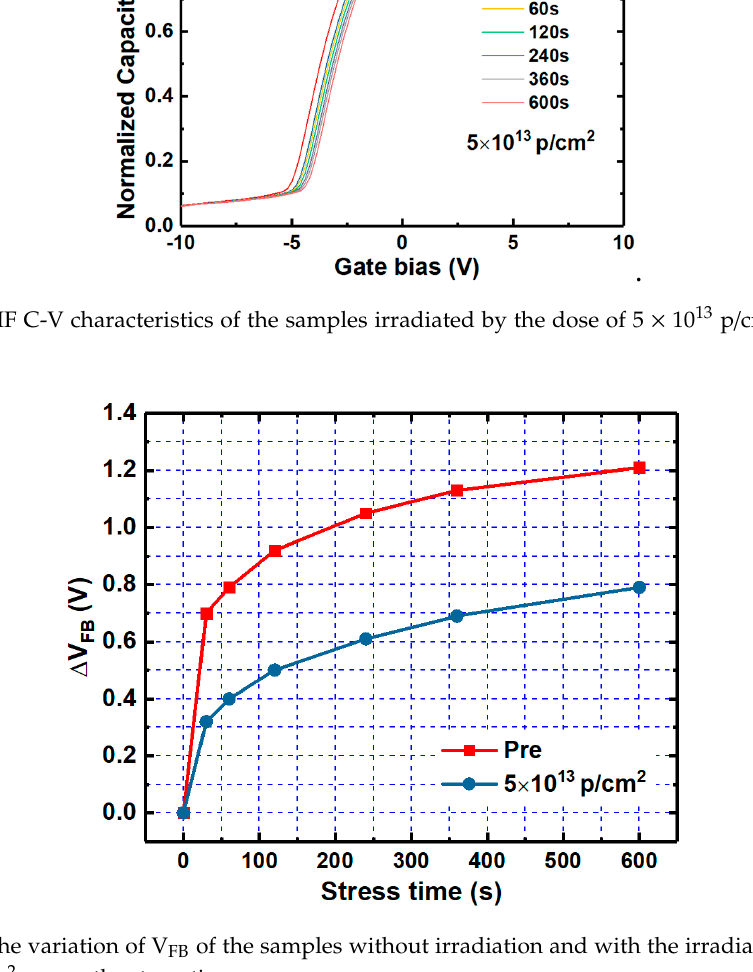
Figure 23. The variation of V FB of the samples without irradiation and with the irradiation dose of 5 × 10 13 p/cm 2 versus the stress time.